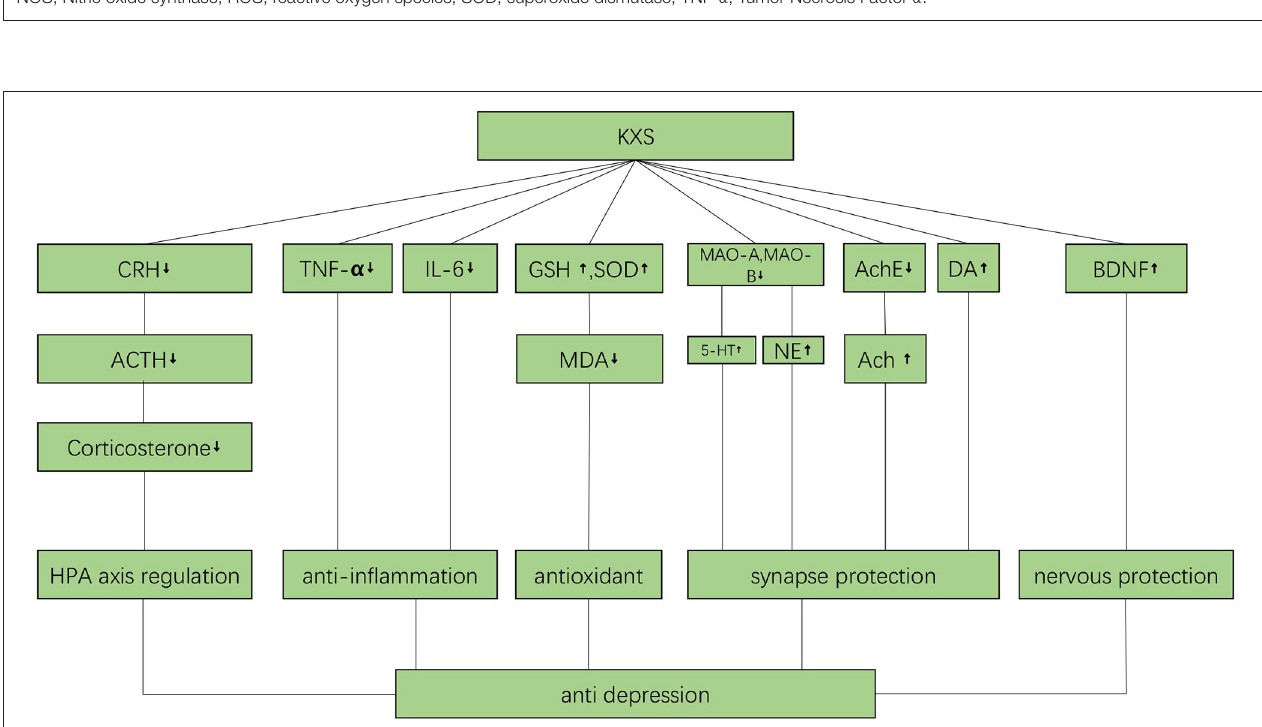
FIGURE 9 | The possible mechanisms by which KXS may ameliorate depression. Ach, acetylcholine; AchE, Acetyl cholinesterase; ACTH, Adreno cortico tropic hormone; BDNF, brain derived neurotrophic factor; CRH, Corticotropin releasing hormone; DA, Dopamine; GSH, glutathione; IL-6, interleukin-6; MAO-A, Monoamine oxidase-A; MAO-B, Monoamine oxidase-B; MDA, malondialdehyde; NE, Norepinephrine; TNF- α , Tumor Necrosis Factor α ; 5-HT, 5-hydroxytryptamine.